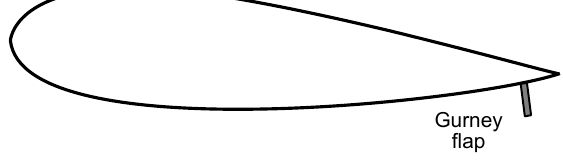
Figure 6. Gurney flap at the trailing edge on the blade pressure